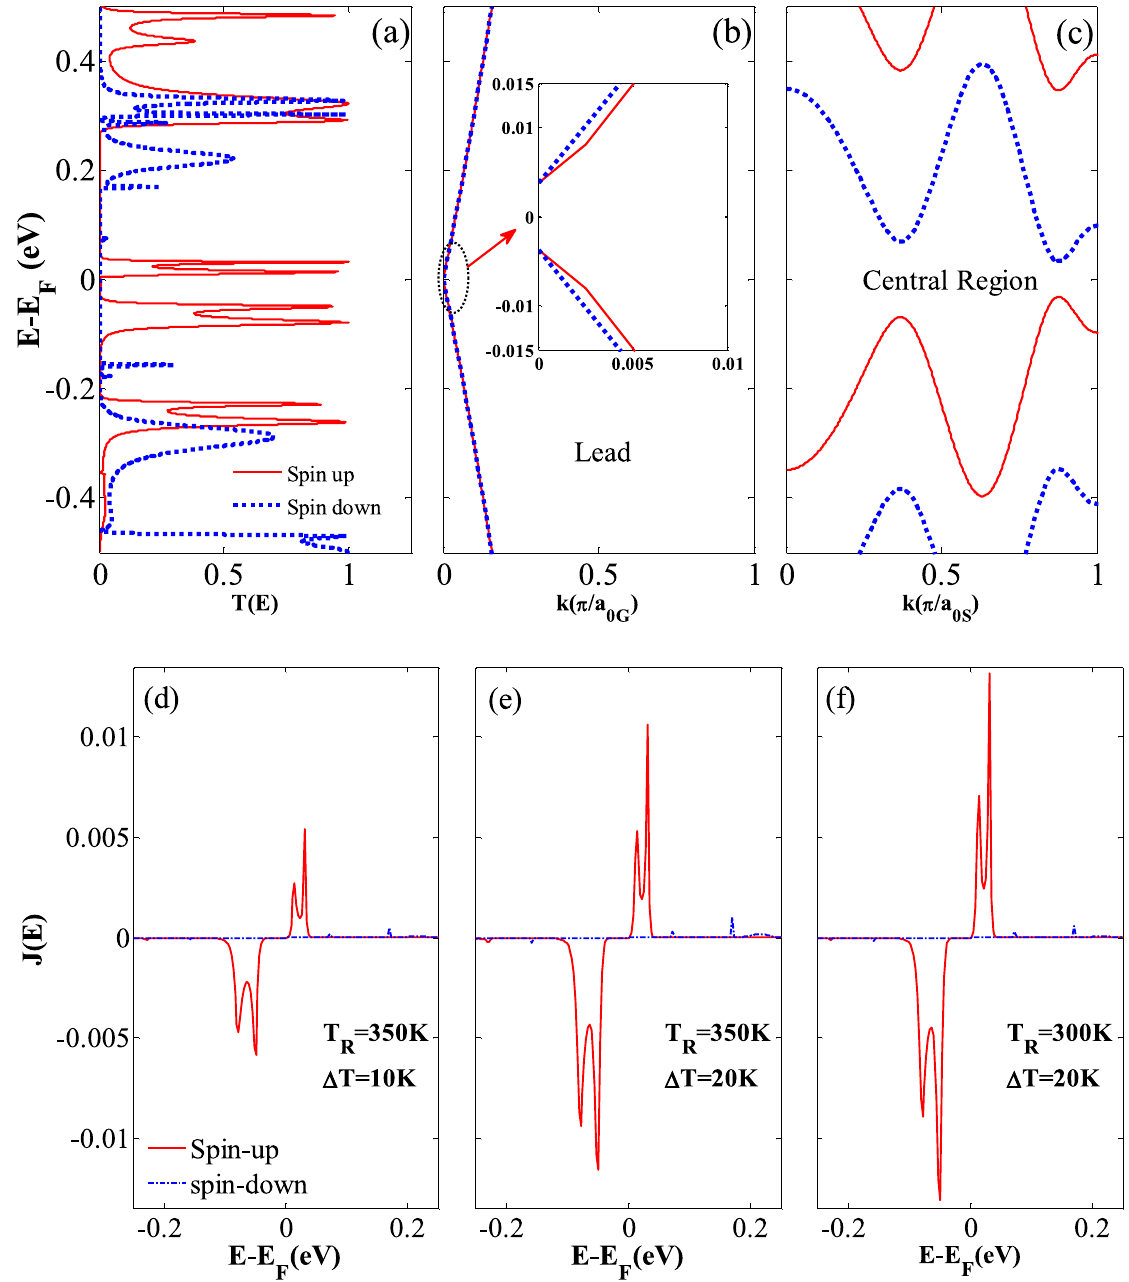
Figure 6. ( a ) The spin-dependent transmission spectra ( T up and T dn ) versus E − E F , ( b ) the band structures of the right (left) lead with an applied electric field of E y G = 0.029 V/Å (inset shows the spin splitting induced by the electric field is very small and negligible) ( c ) the band structures of the ferromagnetic central region including an exchange field of M z = 0.157 eV, electric fields of E Z = 0.030 V/Å, and E y S = 0.575 V/Å, and the variation of the spin-dependent current spectrum J ( E ) for (d) T R = 350 and ∆ T = 10 K, ( e ) T R = 350 and ∆ T = 20 K, and ( f ) T R = 300 and ∆ T = 20 properties and yields a nearly perfect SFE. However, the spin-down transmission is almost zero within this range of energies. Like in SDSE case, the combined effects of external fields on the hybrid GSNRs are also evaluated for the SFE case and similar results are obtained. Figure 6(b),(c) shows the band structures of the leads and central region for the considered hybrid GSNRs, respectively. As shown in Fig. 6(b), the spin-dependent subbands of the leads are almost matched, whereas the lowest-energy subbands of the central region belong to two different spin states (see Fig. 6c). As can be seen from Fig. 6(c), the ferromagnetic exchange field ( M z = 0.157 eV) causes different spins to shift in opposite directions. The semiconducting gaps are also generated between the hole and electron subbands when a perpendicular and/or transverse electric fields ( E z = 0.030 V/Å, E y S = 0.575 V/Å and E y G = 0.029 V/Å) are applied. However, the transverse electric field causes the electron states to shift to the lower